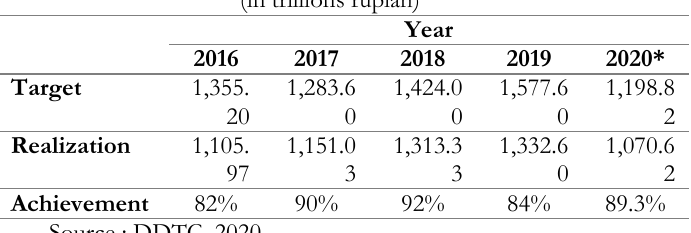
Table 3 Indonesia’s Tax Ratio